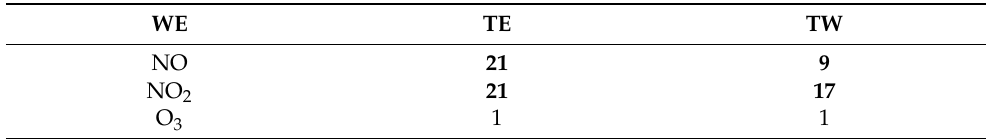
Table 7. The number of extreme values out of 24 in 2020 using averaged hourly data from April to June for weekends. p -Values < 0.05 for 9 or more and p -values < 0.01 for 11 or more are both shown in bold. The extremes for ozone are maximum values; the extremes for NO and NO 2 are minimum